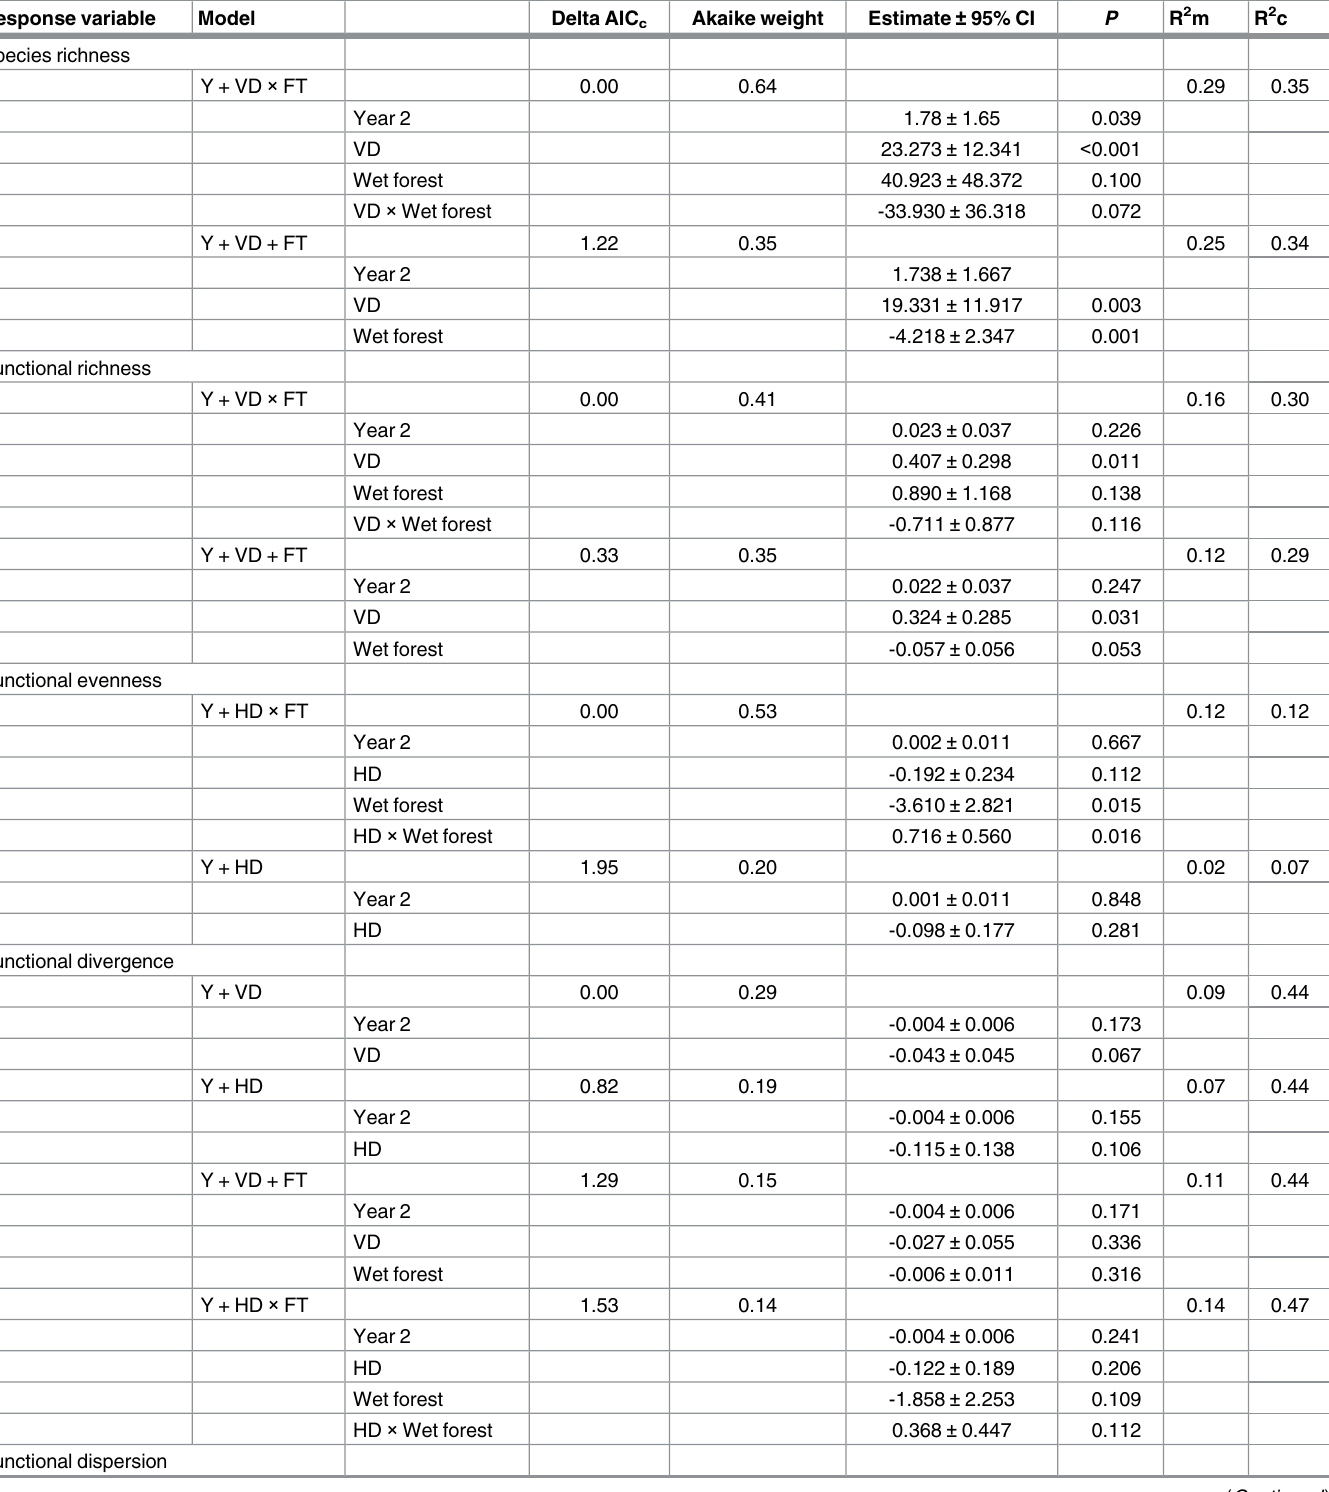
Table 1. Responses of bird species richness and functional diversity to vertical (VD) and horizontal vegetation diversity (HD) in different forest types (FT) and years (Y) derived from linear mixed